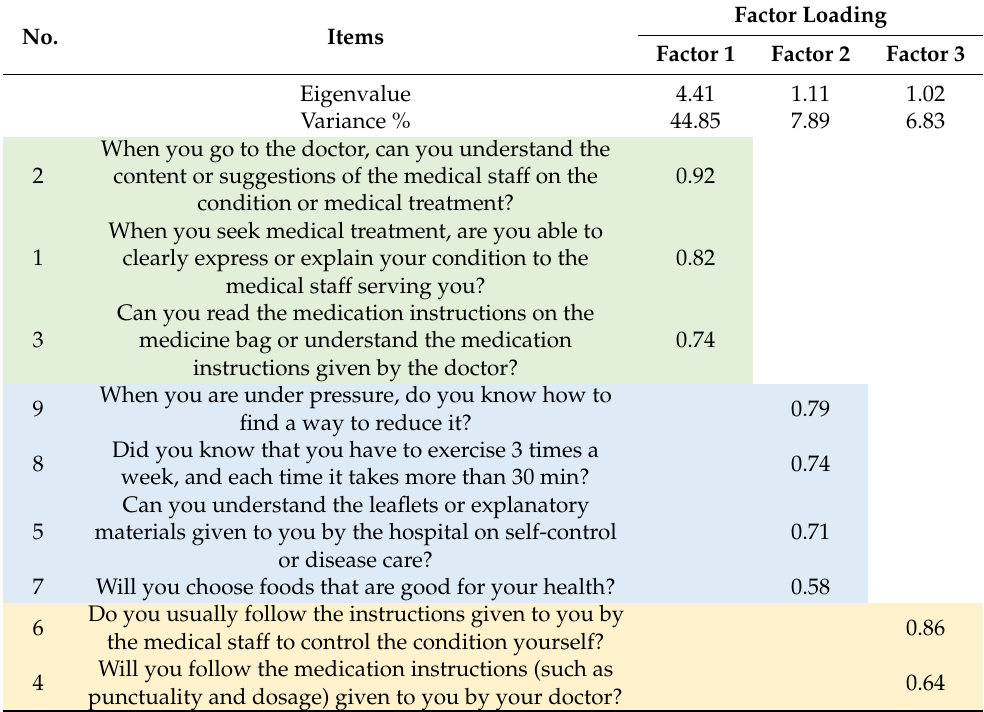
Table 2. Factor analysis and factor loadings of the health literacy scale (n =